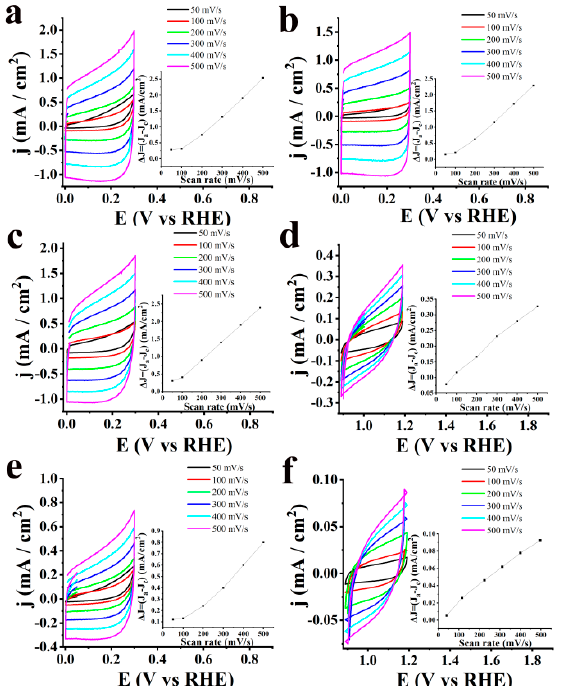
Figure 5. Cyclic voltamographs for OER of S-CNHs ( a ) before and ( b ) after 2000 cycles, ox-CNHs ( c ) before and ( d ) after 2000 cycles and pristine CNHs ( e ) before and ( f ) after 2000 cycles measured in a nitrogen saturated aqueous 1.0 M KOH, at a rotation speed of 1600 rpm and scan rates from 50 to 500 mV/s. Inset: Scan rate dependence of the current densities for the corresponding materials. Next, the electrochemical properties of S-CNHs against HER were evaluated by performing LSV measurements in N 2 -saturated 0.5 M aqueous H 2 SO 4 . The polarization curves of S-CNHs, along with ox-CNHs and pristine CNHs as well as commercially available 20 wt% Pt on carbon black (Pt/C) as reference materials, can be seen in Figure 6a. The lowest onset potential is registered at − 0.2 V vs. RHE for S-CNHs, which is more positive by 50 and 120 mV in comparison with the values noted for ox-CNHs (i.e., at − 0.25 V) and pristine CNHs (i.e., at − 0.32 V), respectively. In addition, potential values for HER are often compared at the functional current density for electrochemical water splitting of − 10 mA/cm 2 , where sufficient hydrogen production is achieved, while faulty interpretations from intrinsic electroactivity are prevented. It is clear that S-CNHs show higher electrocatalytic activity at − 0.31 V vs. RHE, shifted by 120 and 440 mV to more positive potentials compared to the value recorded for ox-CNHs (i.e., at − 0.43 V) and pristine CNHs (i.e., at − 0.75 V), respectively.